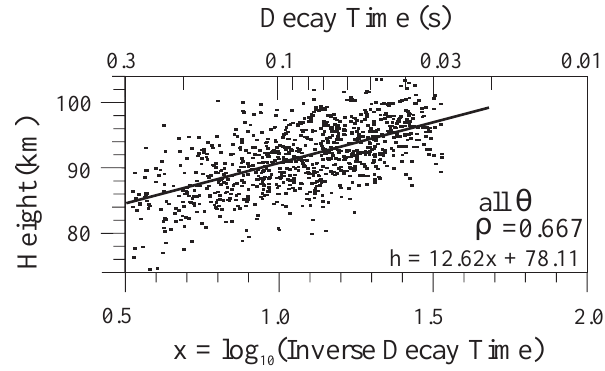
Fig. 3. A graph like that shown in Fig. 1c, but using simulated data and assumed values for errors in K amb , temperature variability and height errors of 27%, 8% and 3.25km,